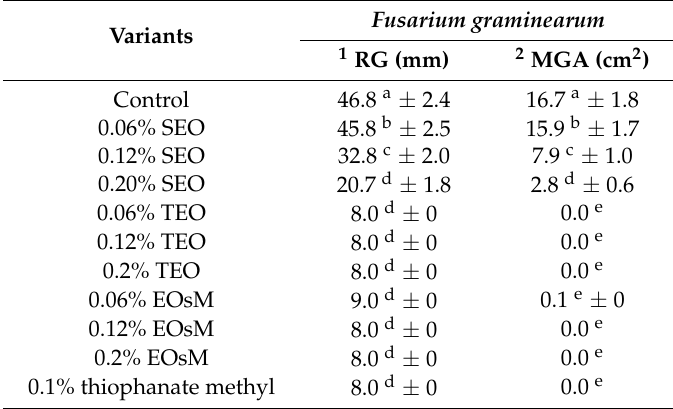
Table 3. Antifungal activity of SEO and TEO on Fusarium graminearum mycelium